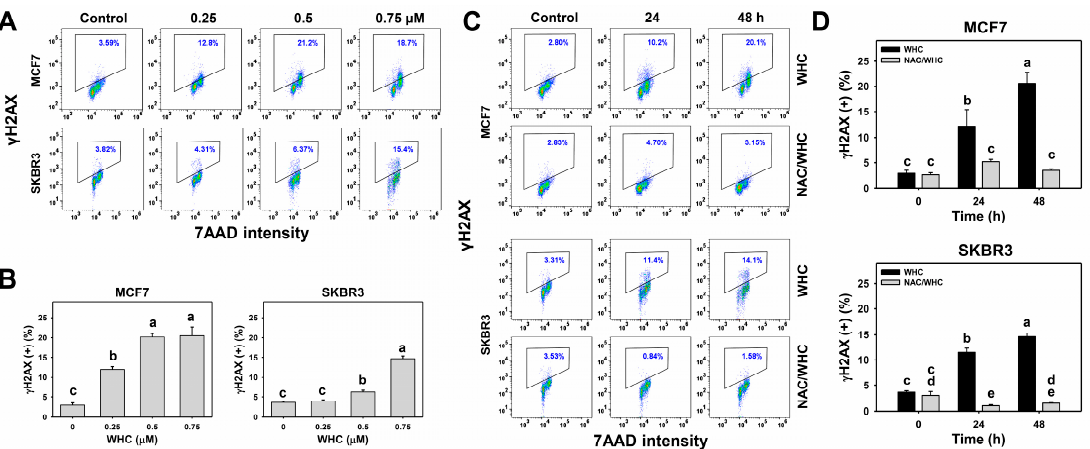
Figure 6. WHC differentially induced DNA double strand break (DSB) damage ( γ H2AX) of breast cancer cells. ( A , B ) γ H2AX profiles and statistics for dose effects on WHC. Breast cancer (MCF7 and SKBR3) cells were treated with WHC (control (0.075% DMSO), 0.25, 0.5, and 0.75 µ M) for 48 h. Box region of each profile is counted for γ H2AX ( + ) (%). ( C , D ) NAC pretreatments reversed the WHC induced γ H2AX generation. Following pretreatments with NAC (10 mM for 1 h), cells were treated with control (0.075% DMSO) and 0.75 µ M of WHC for 0, 24, and 48 h, i.e., NAC / WHC. Data are means ± SDs ( n = 3). Results marked without overlapping letters show significant differences ( p < 0.005 to